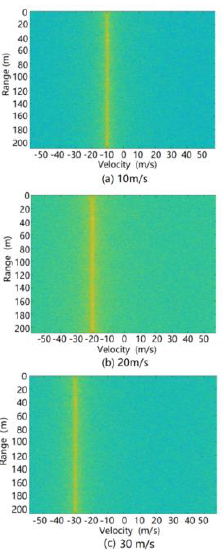
Figure 16. RD spectrum of simulated ground clutter at different speeds of radar-carrying vehicles.